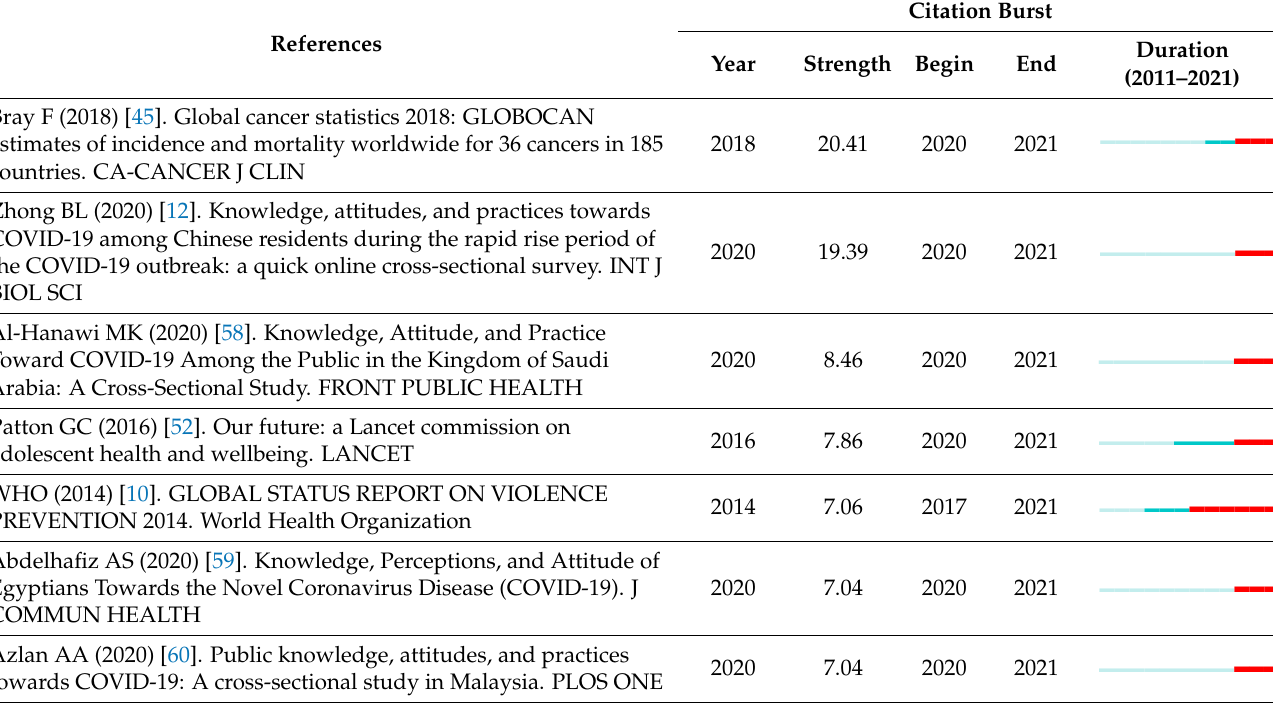
Table 6. References with recent citation bursts.